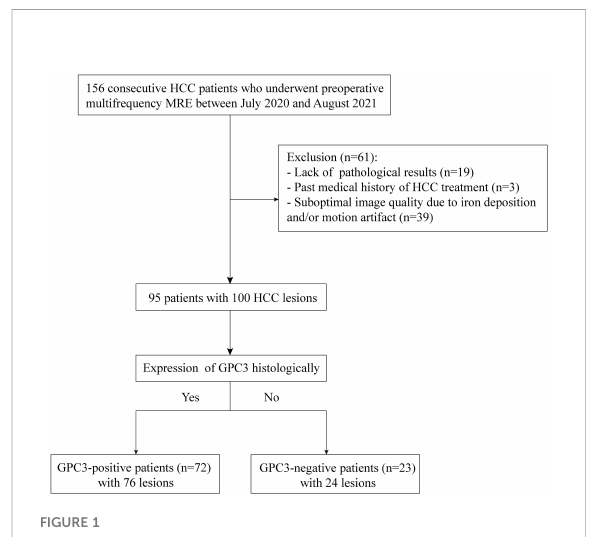
FIGURE 1 Flowchart of participant inclusion and